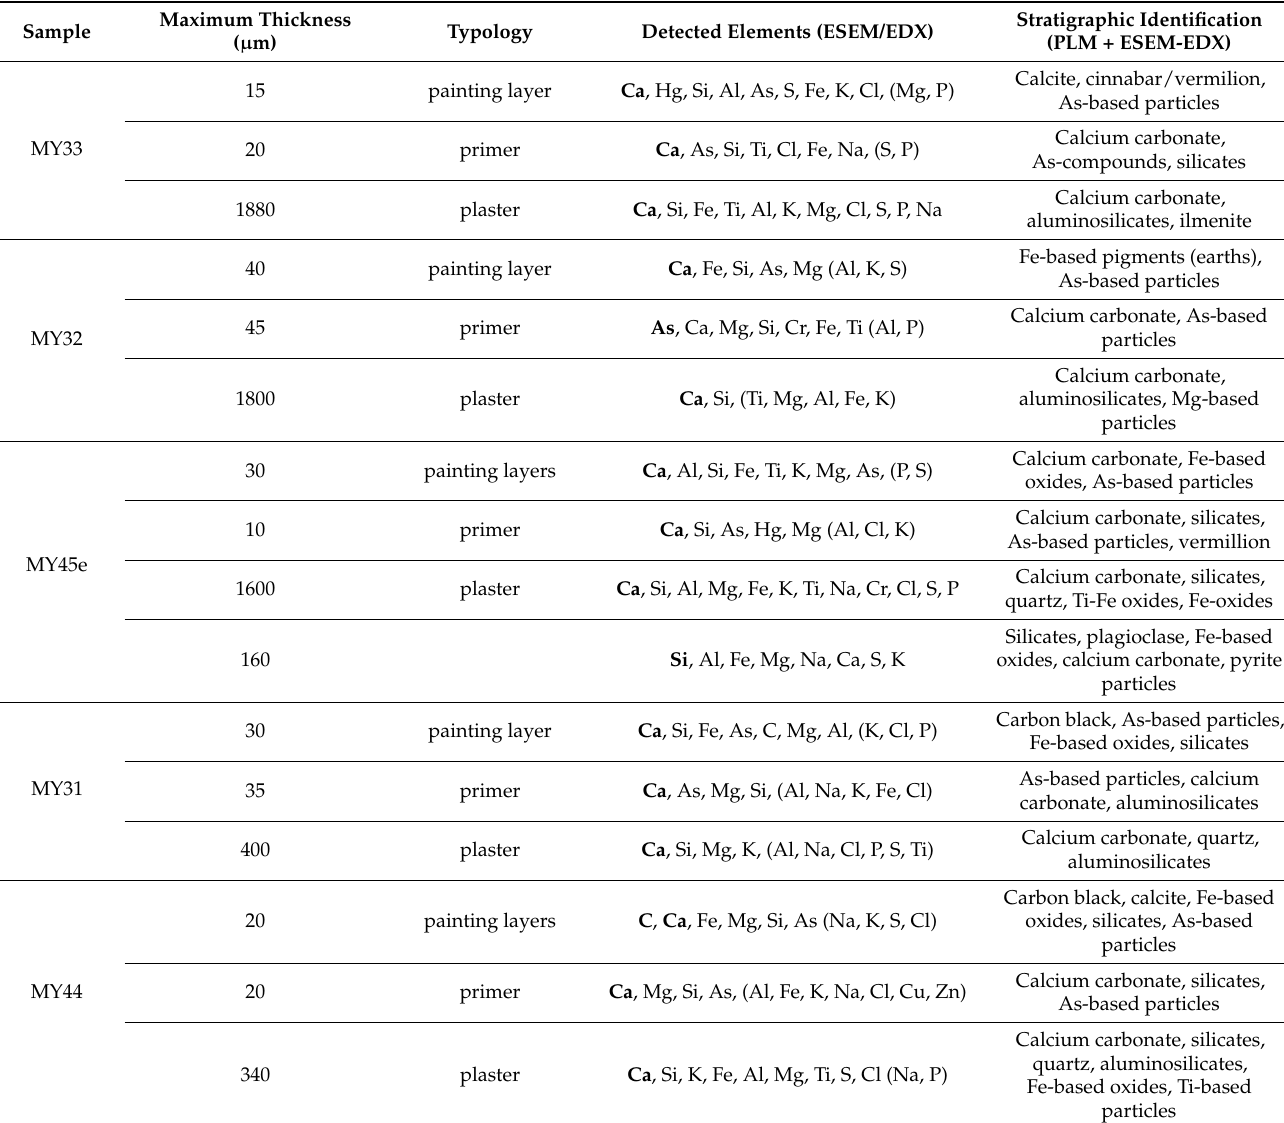
Table 3. Stratigraphic composition of paint